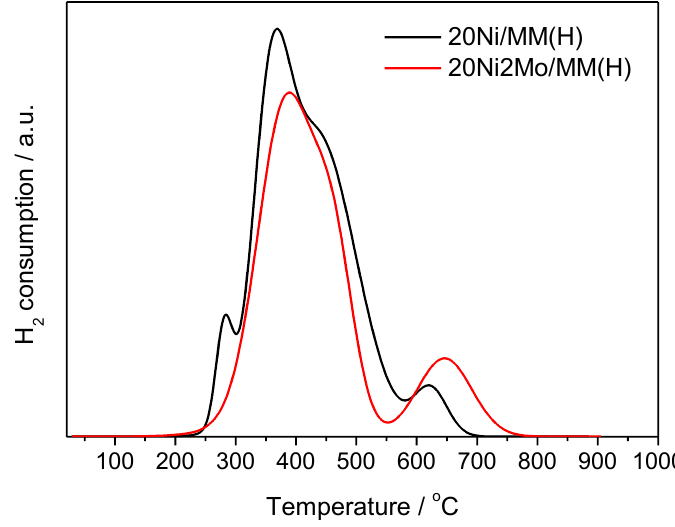
Figure 9. H 2 – TPR profiles of the 20Ni/MM(H) and 20Ni2Mo/MM(H) samples. Figure 9. H 2 –TPR profiles of the 20Ni/MM(H) and 20Ni2Mo/MM(H) samples.